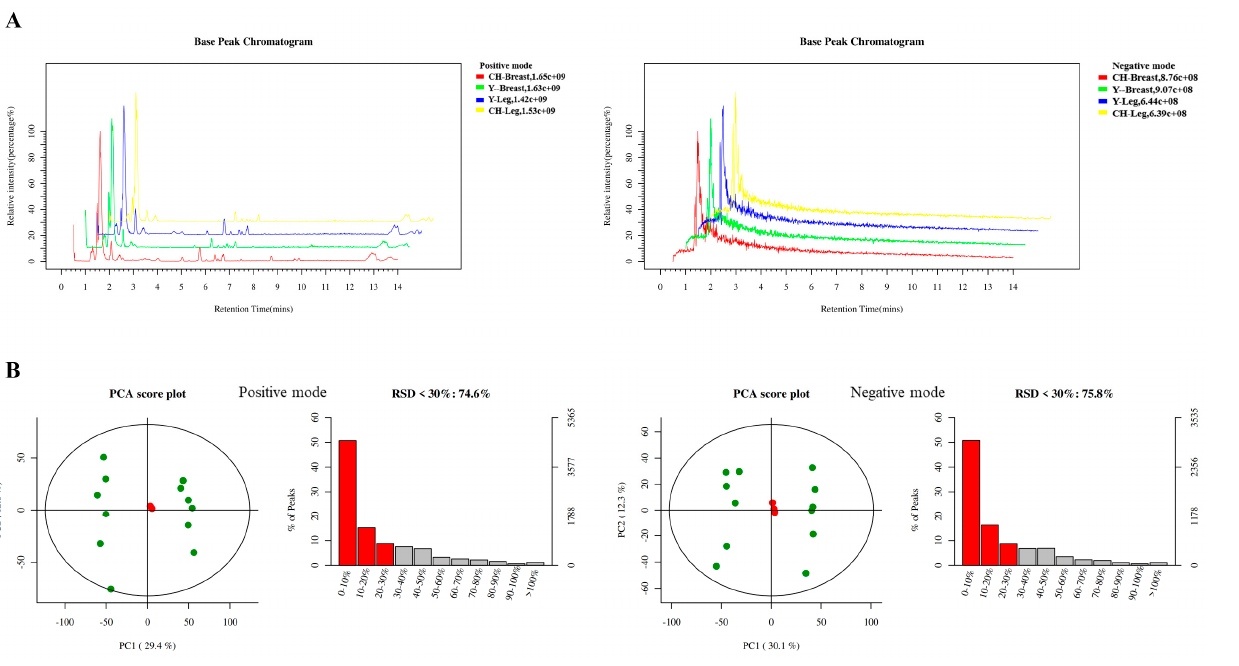
Figure 2. Metabolome quality control and quality assurance. ( A ) BPC diagram of positive and negative ion modes of samples. ( B ) PCA score chart of positive and negative ion mode of sample quality control.